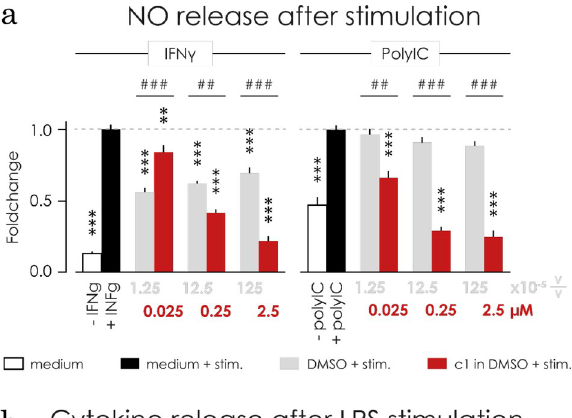
chemoattractant properties. The ATP induced chemotaxis (set to 100%) was not changed by C1 (103%) or DMSO (112%) ( Fig 3A ). Motility was assessed in the presence of 2.5 μ M C1, DMSO (125x10 -5 v/v), or plain medium on both sides of the Boyden-chamber. C1 increased microglia motility when